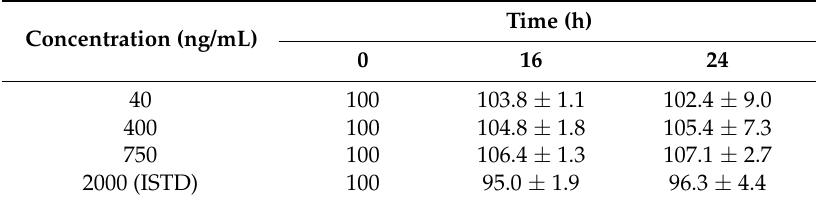
Table 2. Stability of QC samples of FTS and ISTD in